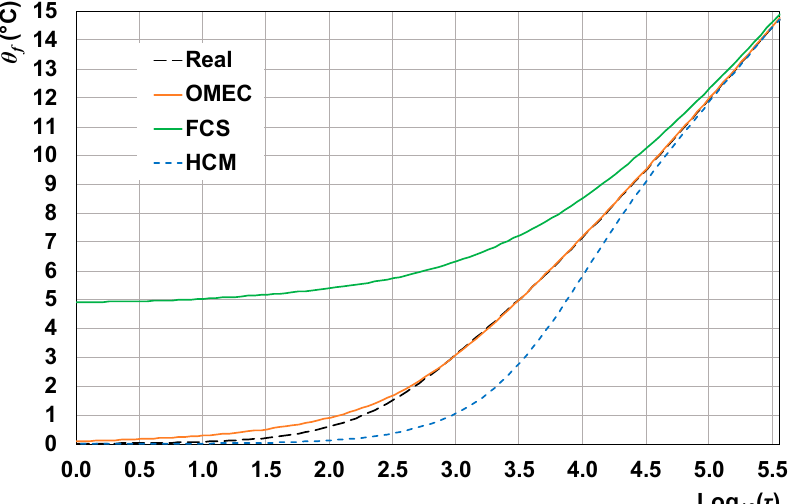
Figure 3. Mean-fluid-temperature rise versus the logarithm of time in seconds, for the real BHE and for the three BHE models.